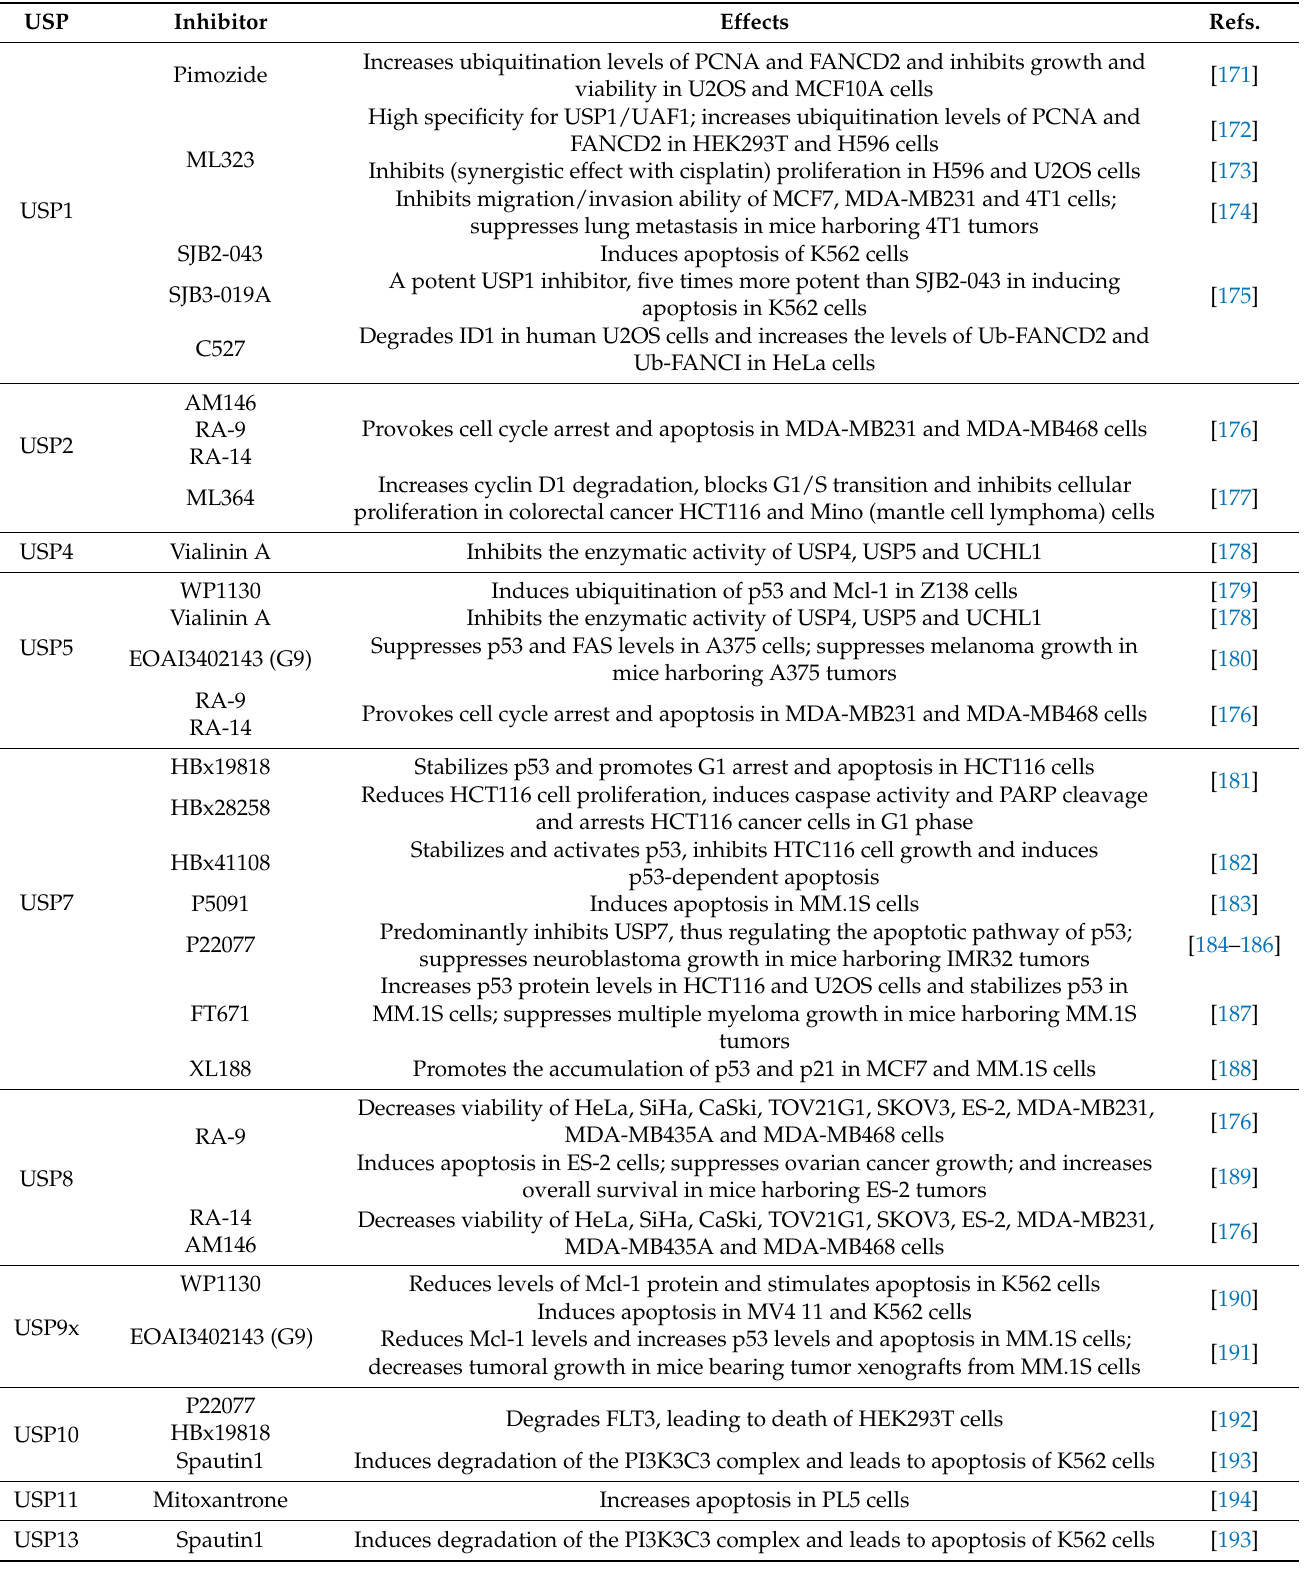
Table 7. List of some inhibitors reported to target USPs and their cellular